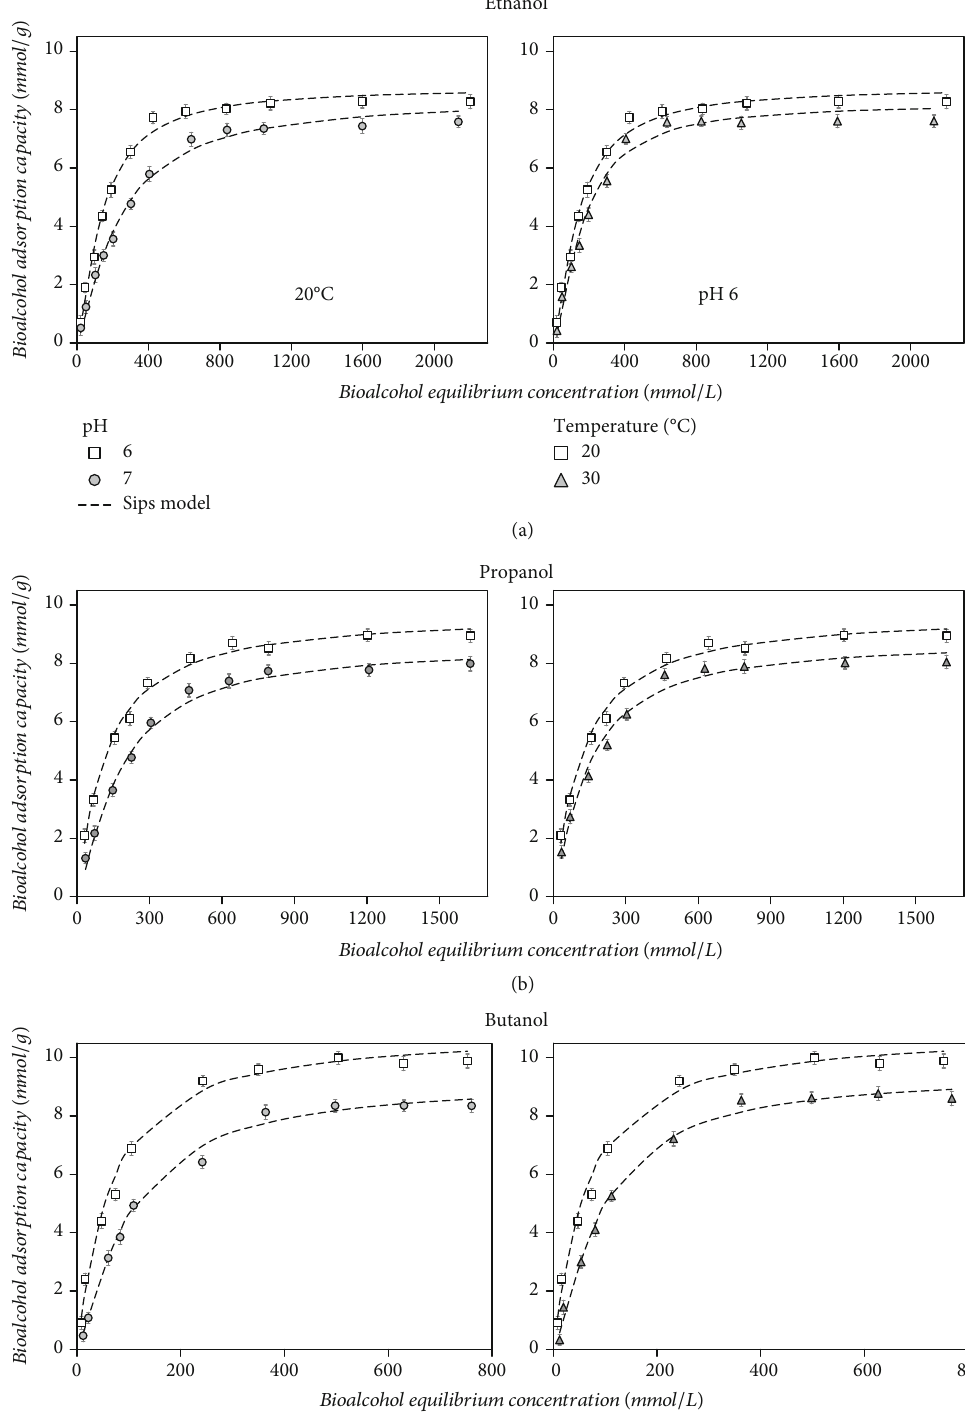
Figure 4: Adsorption isotherms of ethanol, propanol, and butanol on bone char in aqueous solutions at di ff erent conditions of pH and coe ffi cients (i.e., R 2 ≥ 0 : 99 ) for the three bioalcohols. The per- formance of isotherm equations to correlate bioalcohol adsorption with bone char followed the next trend: Sips > Langmuir > Freundlich .